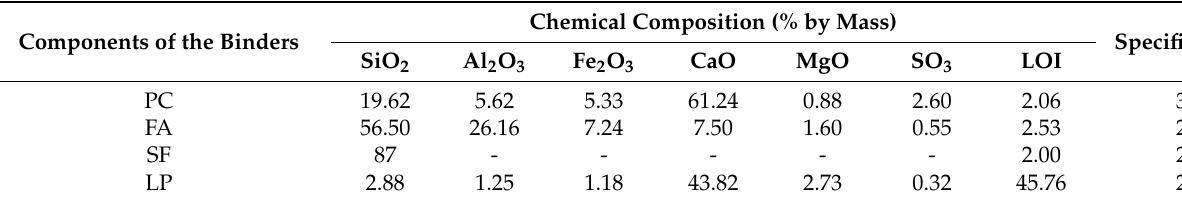
Table 1. Chemical composition of binders.